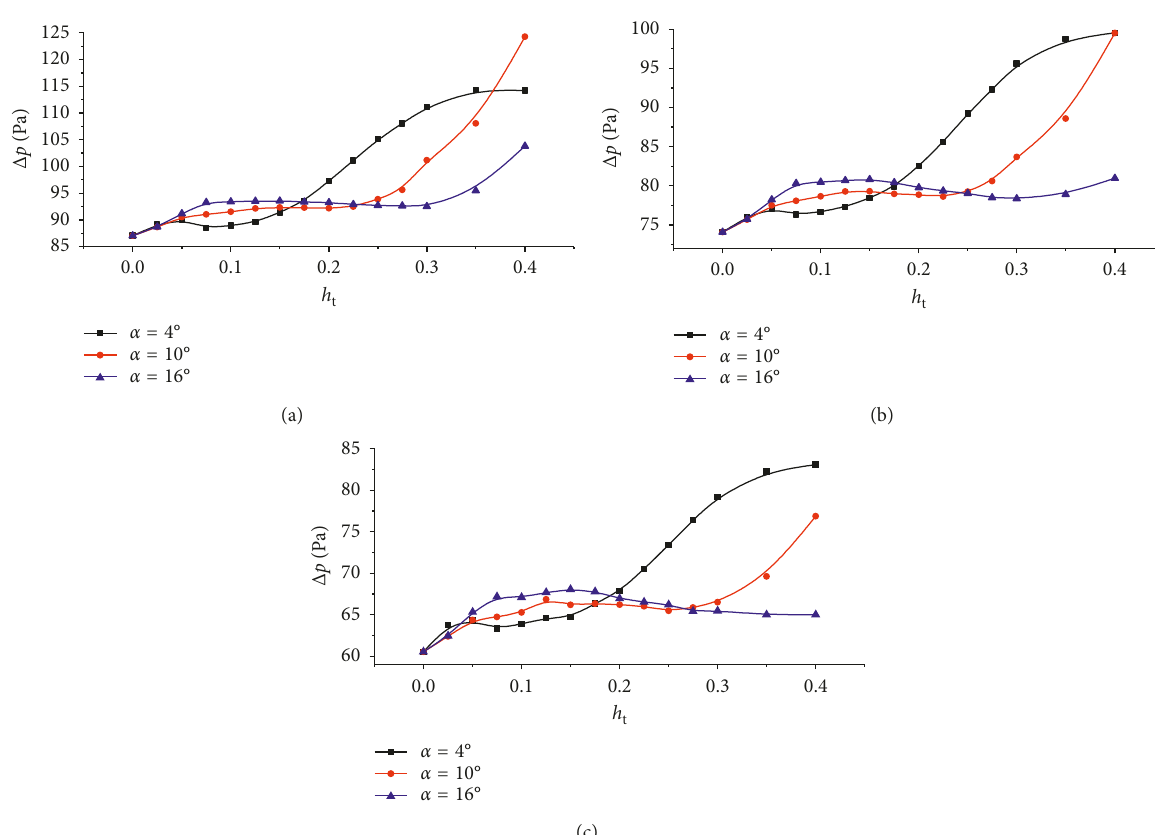
Figure 7: Curves of static pressure with h